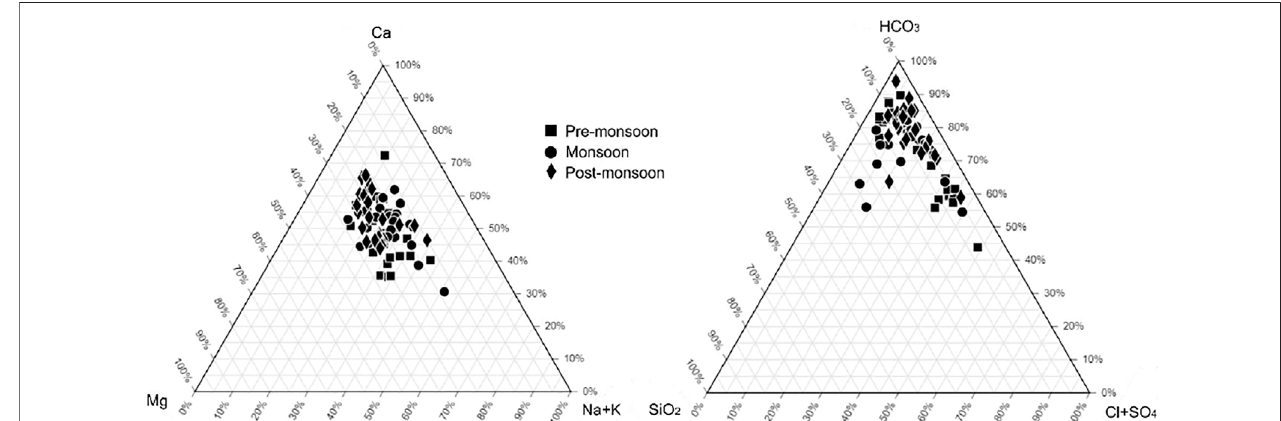
FIGURE 5 | Ternary diagrams of major cation and anion composition of the Ramganga River and its tributaries.